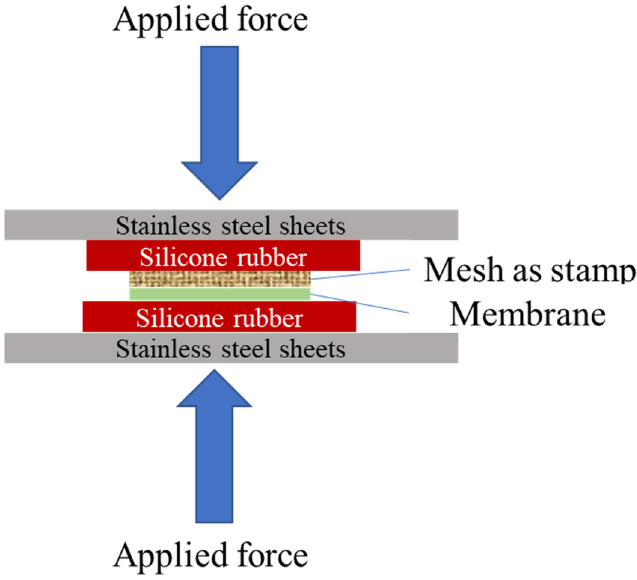
Figure 1. Experimental method for patterning membrane samples by thermal embossing. The patterned and as-received PVDF membranes were labeled by 5-DTAF. First, the membrane surfaces were activated by plasma treatment (model PRC-32G, Harrick PLASMA, Ithaca, NY, USA) for 3 min at 13.33 Pa according to Singh et al. [36]. Following Marroquin et al. [31], the plasma-treated membranes were contacted with 15 µ g/mL 5- DTAF in 100 mM Na 2 CO 3 solution with 100 mM NaCl at pH 9.6 at 4 °C for 24 h to react 5-DTAF with surface hydroxyl groups. Unbound dye was removed by soaking labeled membranes for 10 min in 20% ethanol (aq) and then PBS.